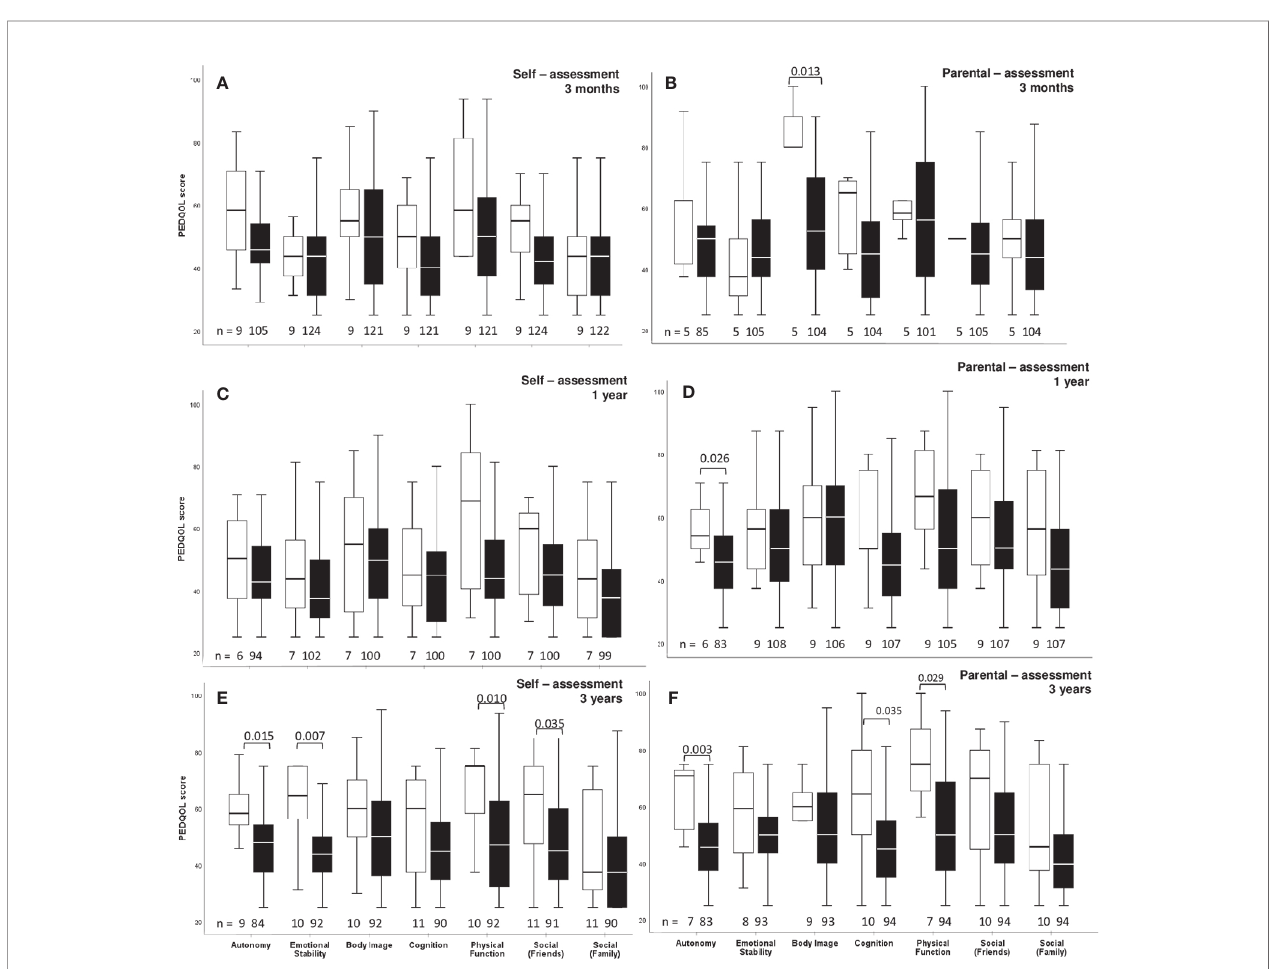
FIGURE 3 | Self-assessment (A, C, E) and parental assessment (B, D, F) of quality of life by Pediatric Quality of Life questionnaire (PEDQOL) in childhood-onset craniopharyngioma (CP) patients, recruited in KRANIOPHARYNGEOM 2007 between 2007 and 2019, with regard to cerebral infarction (CI) con fi rmed by central neuroradiological review. White boxes: CI, and black boxes: no CI. PEDQOL scores are shown as negative rating at the time points three months (A, B) , one year (C, D) , and three years (E, F) after CP diagnosis. The horizontal line in the middle of the box depicts the median. The top and bottom edges of the box respectively mark the 25 th and 75 th percentiles. Whiskers indicate the range of values that fall within 1.5 box-lengths.